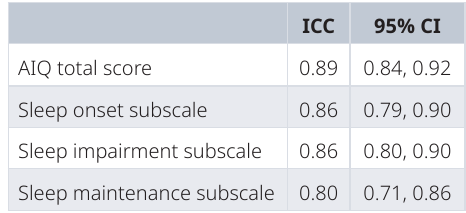
Table 5. Results of the test-retest reliability